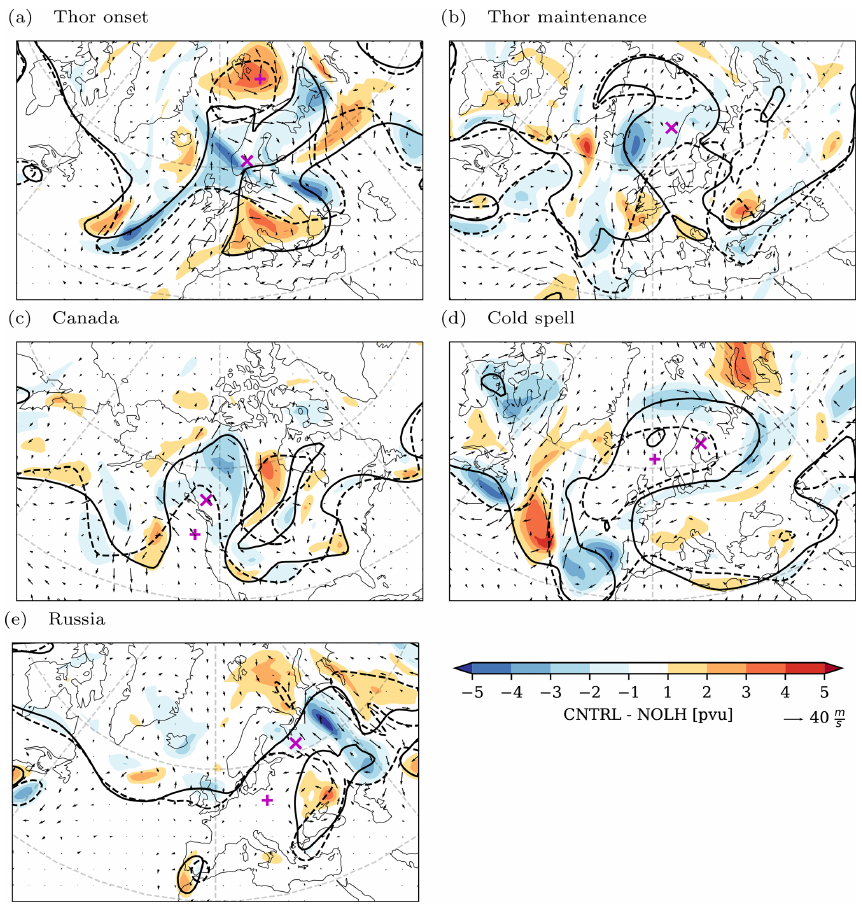
Figure 8. Difference (CNTRL–NOLH) in upper-level PV (shaded in potential vorticity units), difference in upper-level rotational wind (vectors only shown for differences larger than 1ms − 1 ), and upper-level 2pvu contour (solid for CNTRL, dashed for NOLH) after 6d model simulation for (a) Thor onset, (b) Thor maintenance, (c) Canada, (d) Cold spell, and (e) Russia. “x” and “ + ” show locations of blocking centers for CNTRL and NOLH,